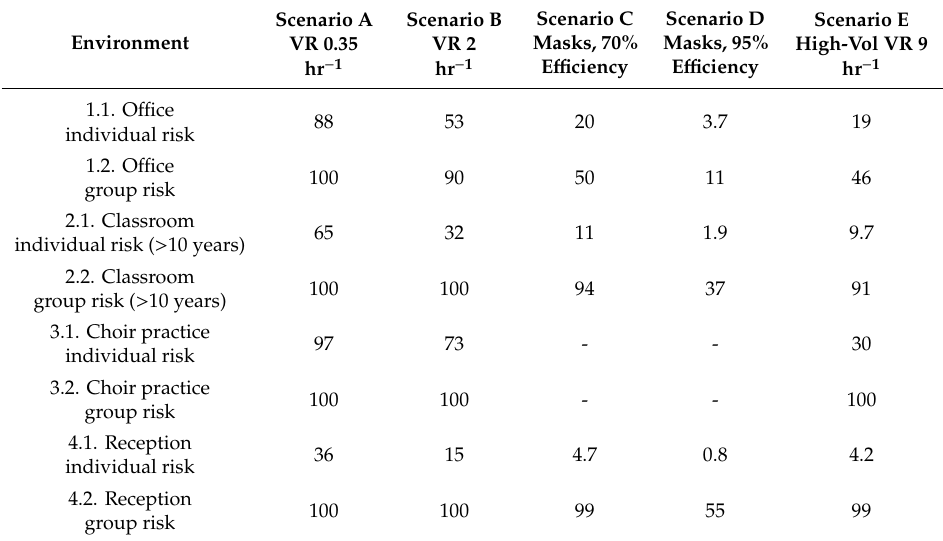
Table 5. COVID-19 infection risk in four example environments for five scenarios. The index subject is assumed to be either super infectious (10 × higher viral load) or a super emitter (10 × higher aerosol emission rate). Unit: percent per episode. The individual risk is that of a particular person being infected, the group risk refers to that of at least one person in the